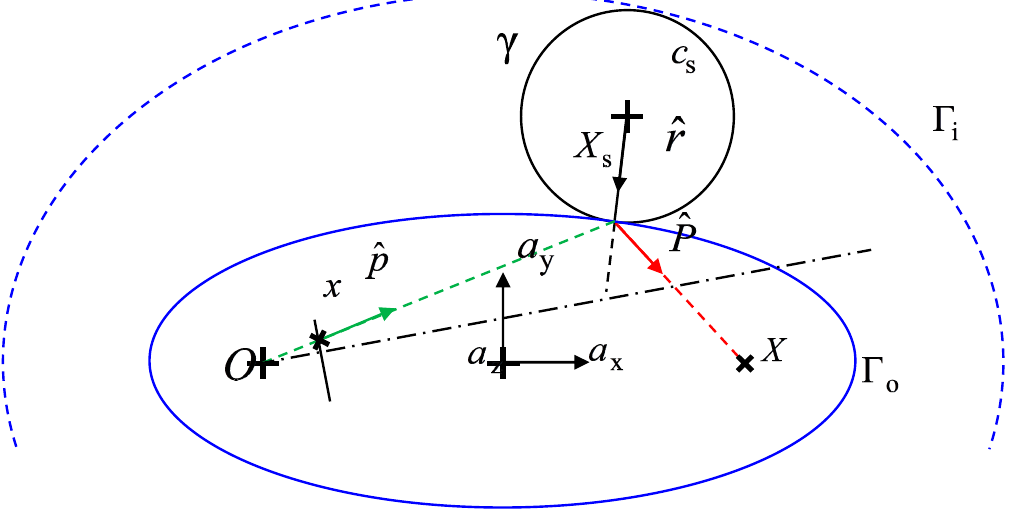
Figure 3. Forward projection geometrical scheme.